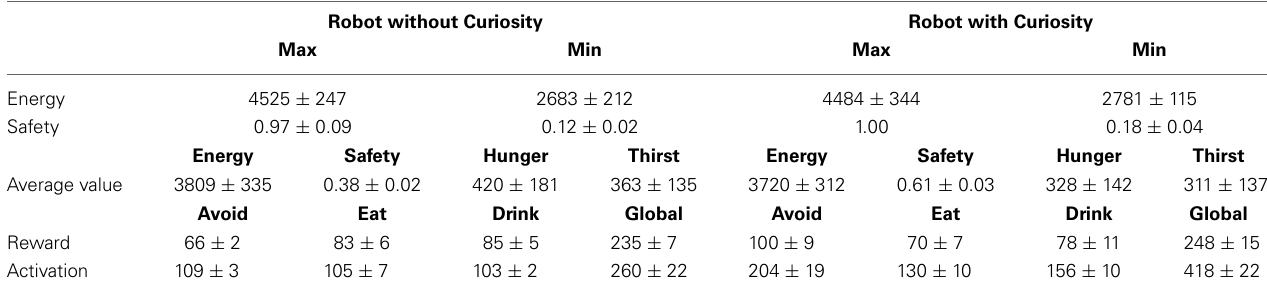
Table 5 | Maximum, minimum and average values for the need functions (safety, hunger and thirst) and the energy function. Robot without Curiosity Robot with